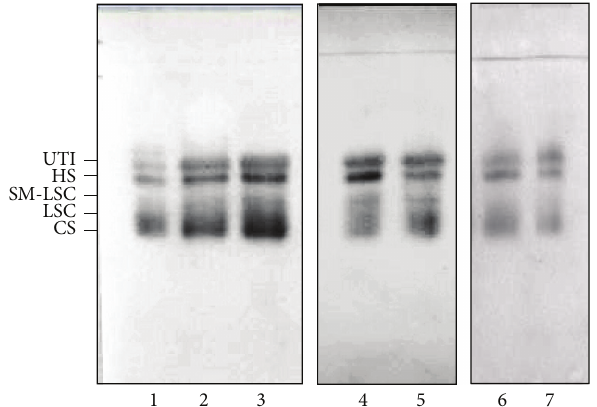
Figure 1: Representative cellulose acetate electrophoretic profiles of urine glycosaminoglycans/proteoglycans from T2DM patients (lanes 1–5) and control subjects (lanes 6-7). UTI: urinary trypsin inhibitor. LSC: low sulfate chondroitin sulfate. SM-LSC: slow migration-LSC. HS: heparan sulfate. CS: chondroitin